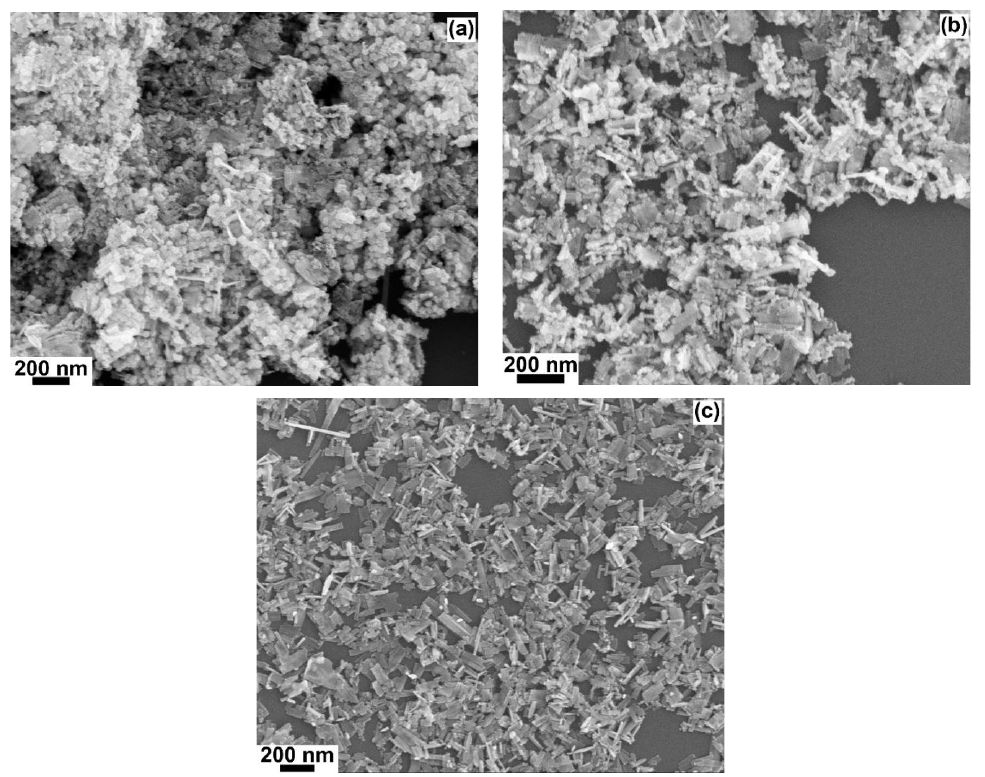
Figure 10. SEM images of Cs 0.3 WO 3 synthesized hydrothermally at 200 °C for 24 h using 0.18 mmol CsCl, 0.4 mmol WO 3 , 8.8 mmol CH 3 CH 2 CHO, and ( a ) 1.5; ( b ) 2.0; ( c ) 2.5 mmol (NH 4 ) 2 C 2 O 4 .